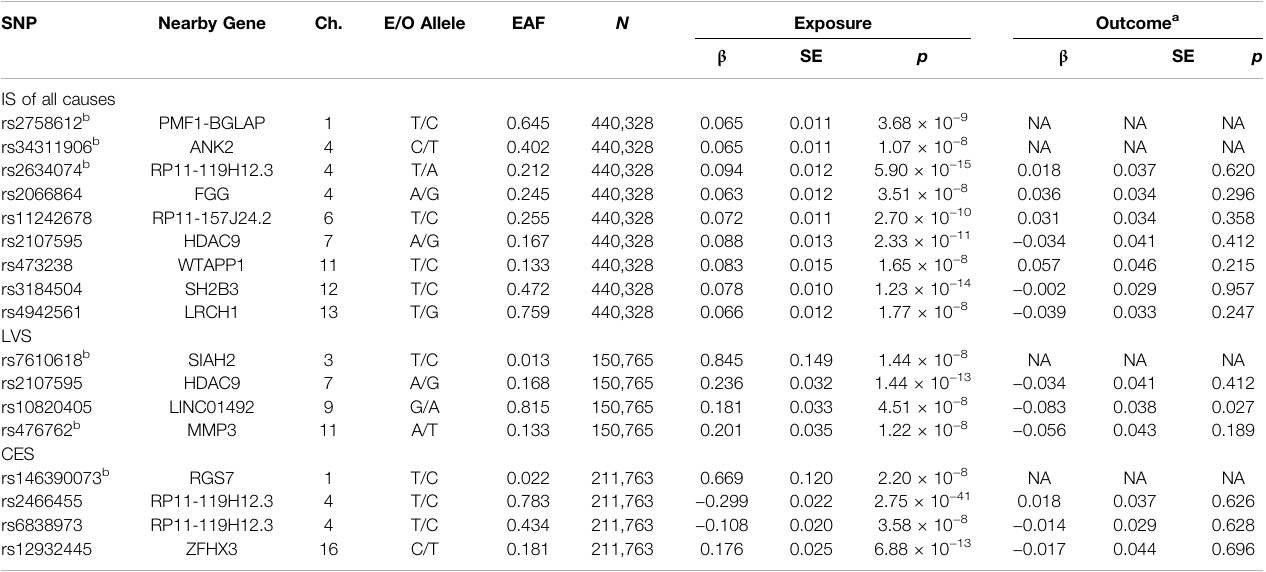
( Supplementary Table S2 and Figure 2 ). Heterogeneity tests